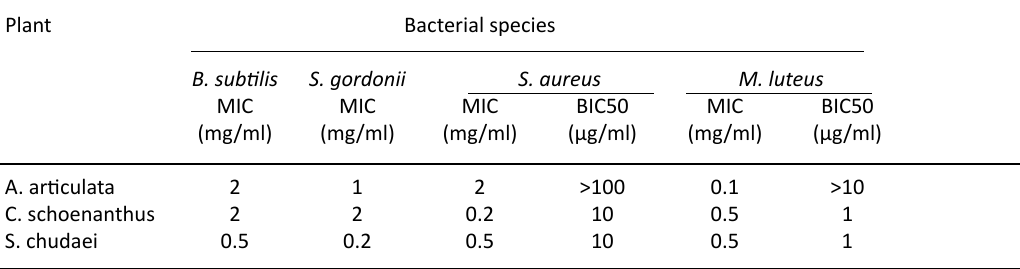
Table 4. Antibacterial activity of methanolic plant extracts against four Gram positive bacteria Plant Bacterial